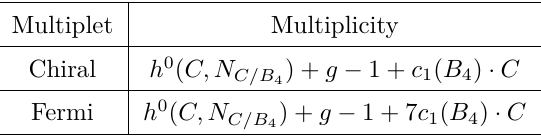
Table 3 . The 2d supermultiplets in the 3-7